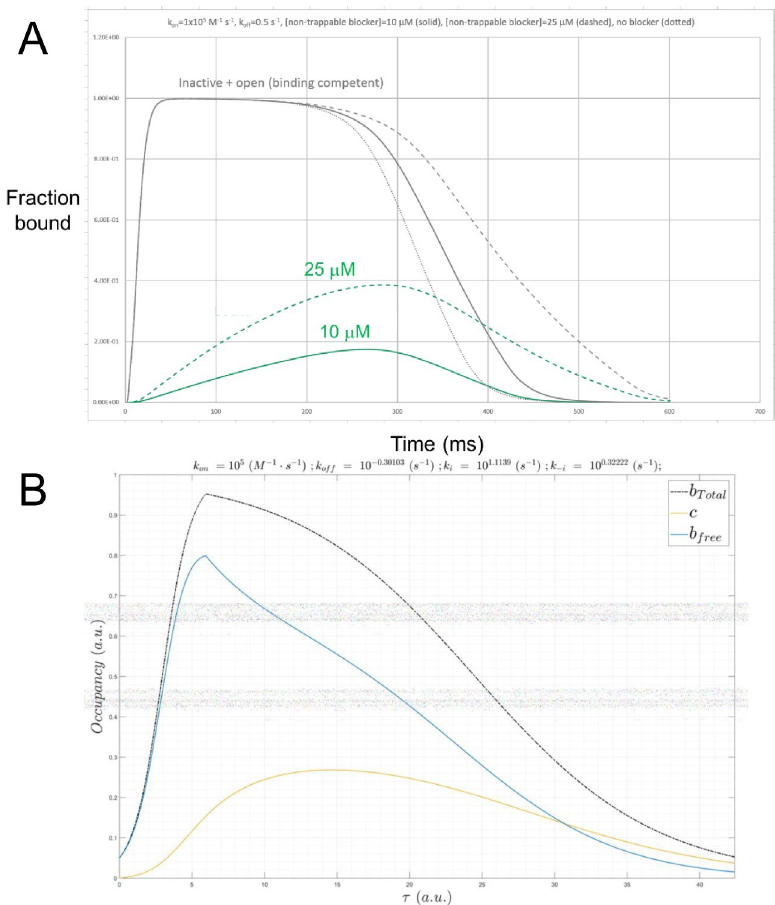
Fig 14. (A) Plot of dynamic fractional hERG occupancy in mid-myocardial (M) cells by a hypothetical non-trappable blocker exhibiting k on = 1x10 5 M -1 s -1 and k off = 5x10 -1 s -1 ( K d = 5 μ M and K 0 = 20 μ M) sampled at 10 and 25 μ M d (green solid and dashed curves, respectively). The total dynamic binding site level consists of the sum of the open/ conducting and inactivated channel populations (gray dotted, solid, and dashed curves corresponding to 0, 10, and 25 μ M blocker concentrations, respectively). The overall shape of the channel state population curves qualitatively resembles our logistic model (in which k is very fast), noting that recovery from inactivation (the decay region of the i curves) is slowed by blockade due to the smaller contribution of the hERG current to the membrane potential, which in turn, alters the response of the channel population (consistent with the recursive effect depicted in Fig 2). The blocker occupancy curves reflect nSSO occupancy at k on = 1x10 5 M -1 s -1 (where k << k , as suggested from on on SS Table 1), and the peak occupancy is far below 50% at 5 μ M. Nevertheless, even transient fractional occupancy approaching the ~45% level can be highly pro-arrhythmic [4]. (B) Plot of B ( τ ) (gray), B ( τ ) (blue) and c ( τ ) (gold) total free simulated using our logistic model (scenario 2) for a hERG blocker exhibiting K d = 5 μ M ( k on = 1x10 5 M -1 s -1 and k off = 0.5 s -1 ) and [free blocker] = 10 μ M. k and k were set to 13 s -1 and 2.1 s -1 , respectively, so as to reproduce B at τ � i − i max 50 ms and Λ � 350 ms. B total ( τ ) and c ( τ ) are qualitatively similar to the curves in